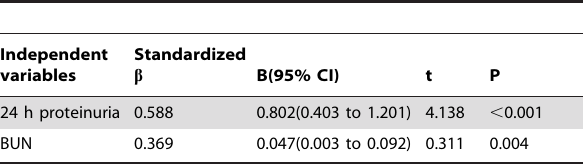
Table 3 Multiple stepwise regression analysis showing variables independently associated with serum CXCL16